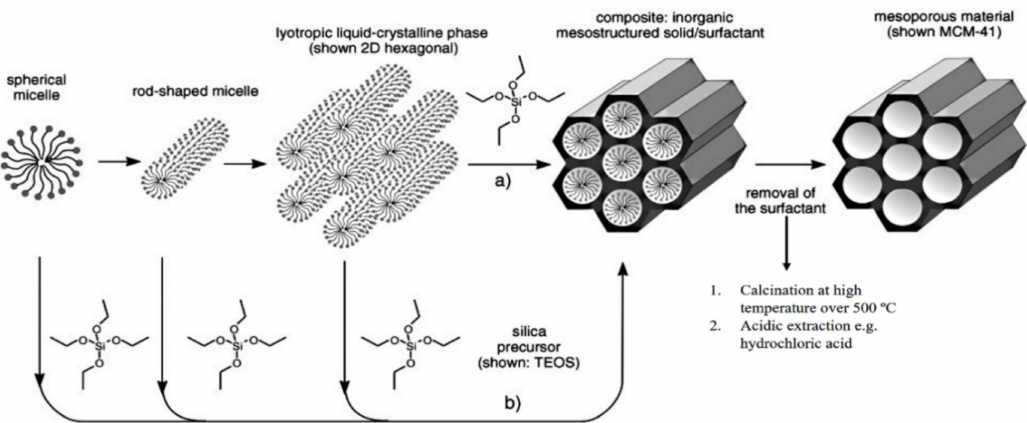
Figure 2. The formation mechanism for mesoporous materials by structure-directing agents. ( a ) True liquid–crystal template mechanism. ( b ) Cooperative liquid–crystal template mechanism. Reproduced with permission from [52], WILEY-VCH Verlag GmbH and Co. KGaA, 2006.